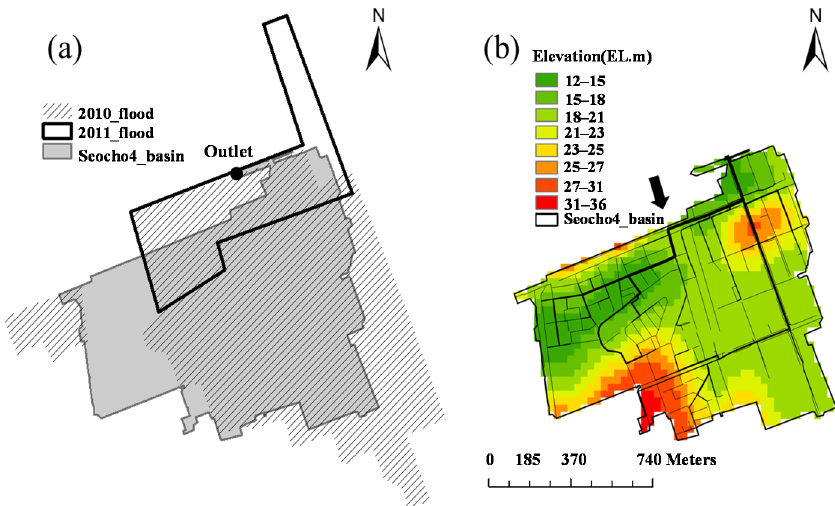
Figure 5. ( a ) Test catchment, Seocho4 with flooded areas reported; ( b ) drainage network and